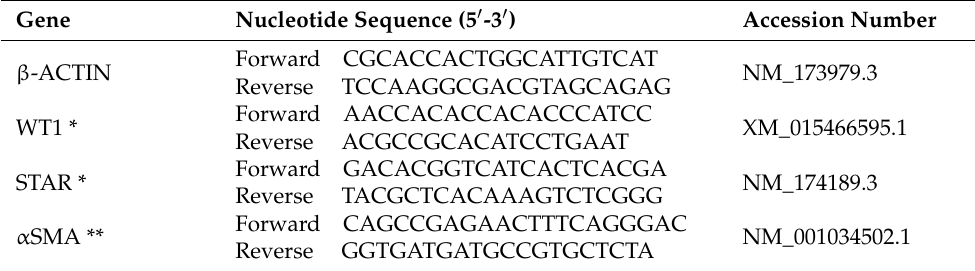
Table 2. Sequence of primers used for Q-PCR